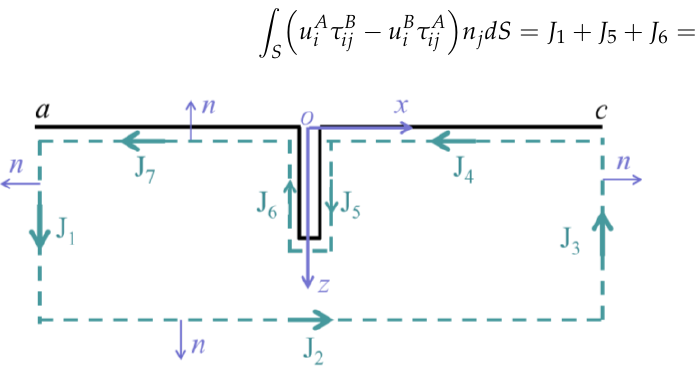
Figure 3. Body and contour of surface crack for the application of reciprocity theorem.